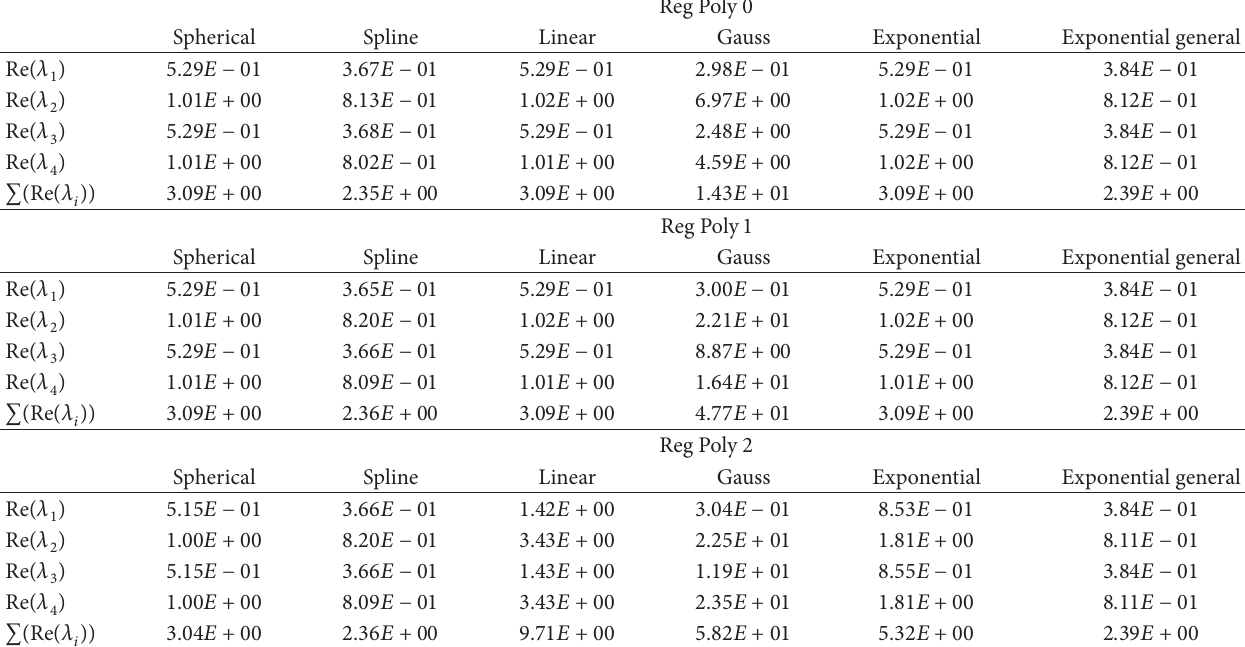
Table 4: Configuration 1: maximum of absolute error on real parts of eigenvalues for different regression and correlation kriging functions. Reg Poly 0 Spherical Spline